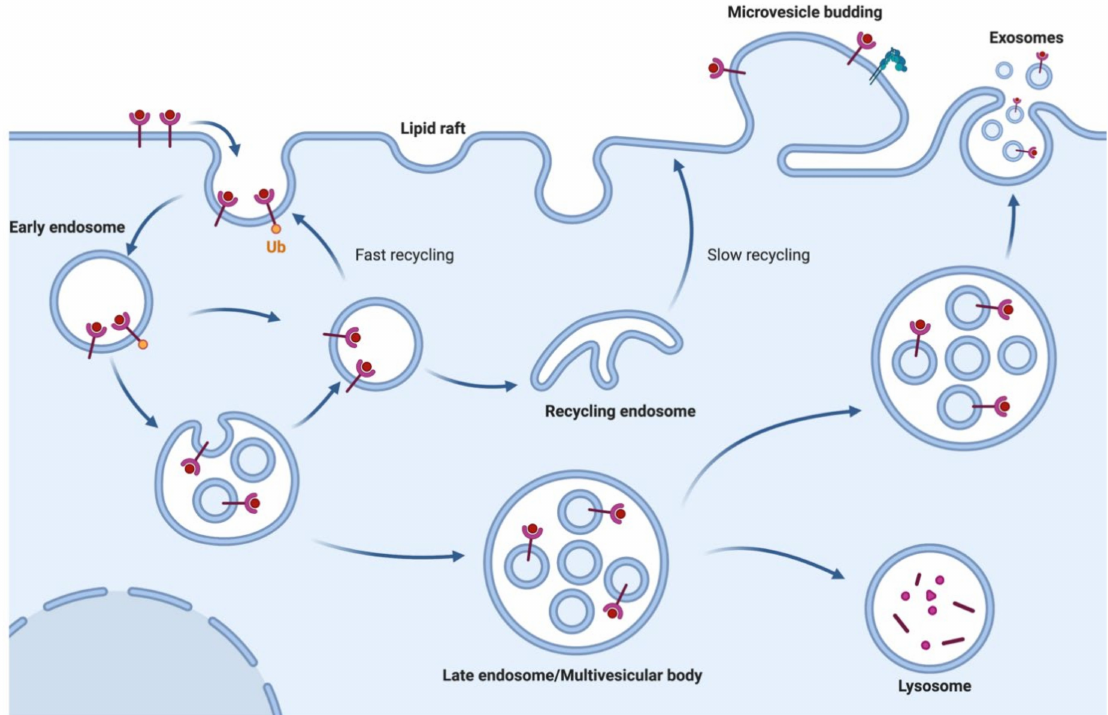
Figure 1. Biogenesis of extracellular vesicles (EVs; exosomes and microvesicles): EVs are broadly classified into two categories: exosomes and ectosomes or microvesicles. Exosomes demonstrate a size range between 40 to 150 nm and are generated through a process that involves double invagination of the endosomal membrane to form multivesicular bodies containing intraluminal vesicles. This process is followed by fusion of the multivesicular bodies to the plasma membrane to produce exosomes. By contrast, ectosomes (i.e., microvesicles) and large vesicles are generated by outward budding of the plasma membrane with a size range of 50 to 1000 nm in diameter. (Figure created with